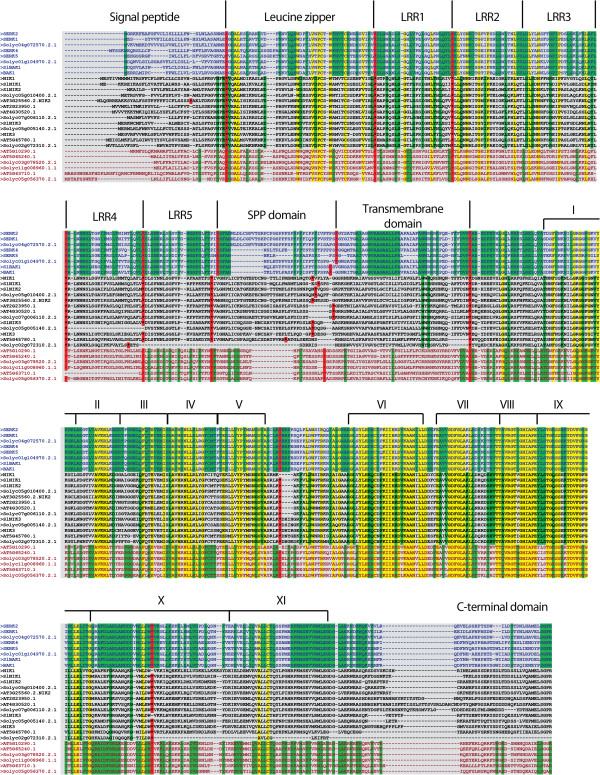
Full-length sequence alignment of LRRII subfamily members of tomato and Arabidopsis demonstrate sequence and structure conservation. Sequences of SERK, NIK and LRRIIc clades members are represented with blue, black and red letters, respectively. Yellow sites represent conserved sites in all sequences, and green sites represent conserved sites in each clade. Red sites represent the exon-exon junctions. Domain structures are indicated above the alignment. Roman numerals delimit the 11 subdomains of the kinase domain.